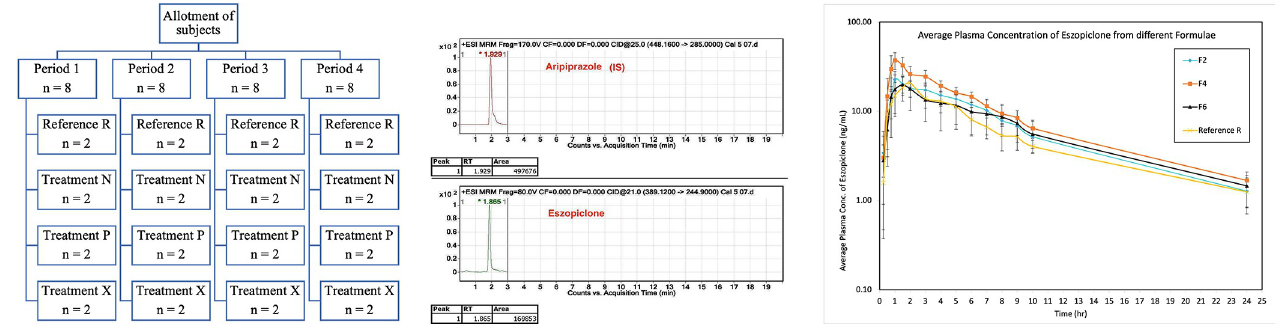
Fig 3. a. Design of Pharmacokinetics study. b. LC-MS_MS chromatograms of Eszopiclone. c. Average plasma drug level of